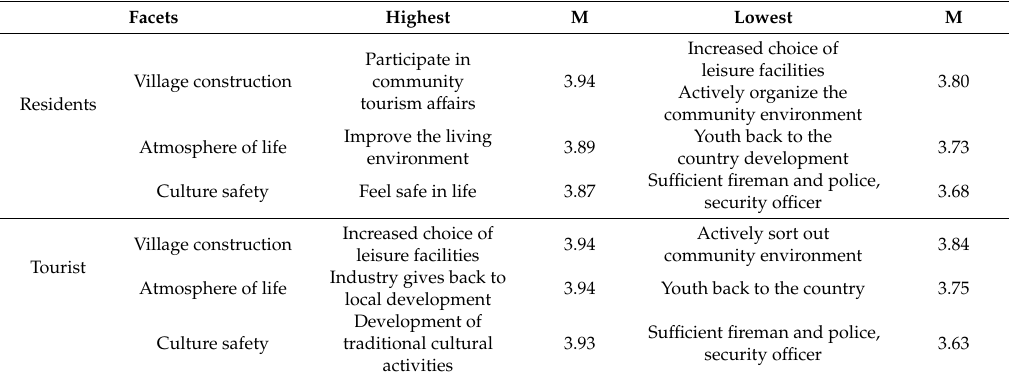
Table 7. The perceptions of the residents and tourists of the current social development. Facets M